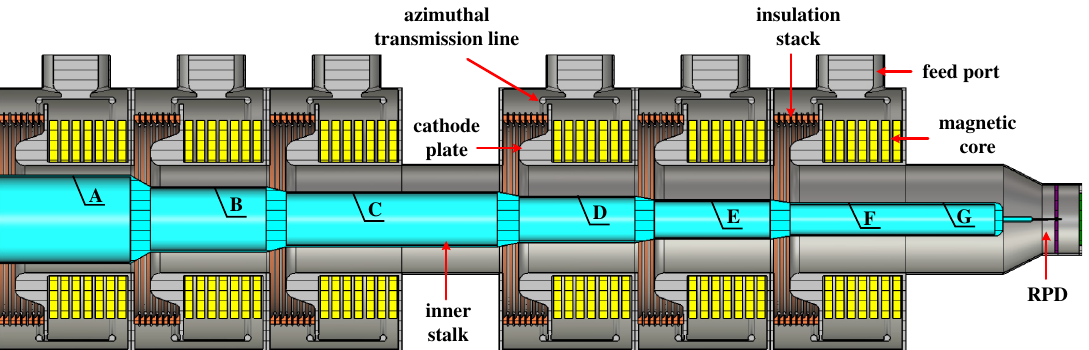
FIG. 8. Schematic cross-sectional view of the voltage adder system which consists of six single feed port induction cavities and an inner stalk. The six cells are divided into two groups. Two coaxial tubes are employed between the third and fourth cavities and at the end of the last cell to accommodate vacuum pumps. A – F indicate the positions of D-dot sensors for detection of the output transmission line voltages. G represents the location of D-dot and B-dot monitors for voltage and current measurement downstream of the last induction cell which is about 45 cm from the RPD. All of these sensors are installed on the inner